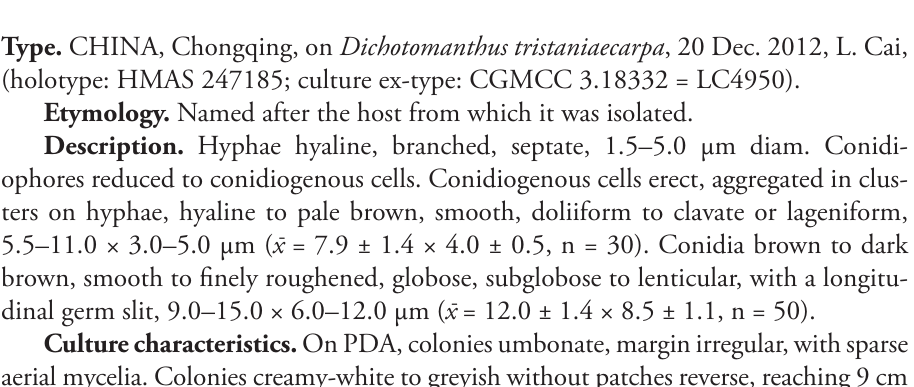
(holotype: HMAS 247185; culture ex-type: CGMCC 3.18332 =